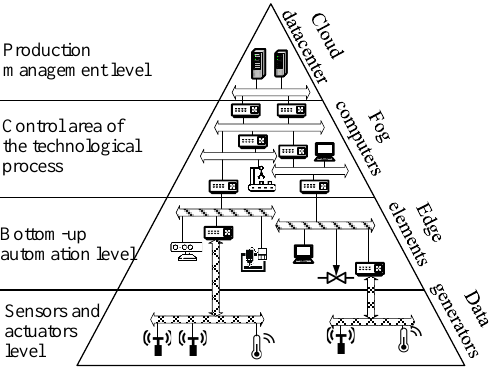
Figure 1. Architecture of the IIS using IIoT elements and Cloud-Fog-Edge